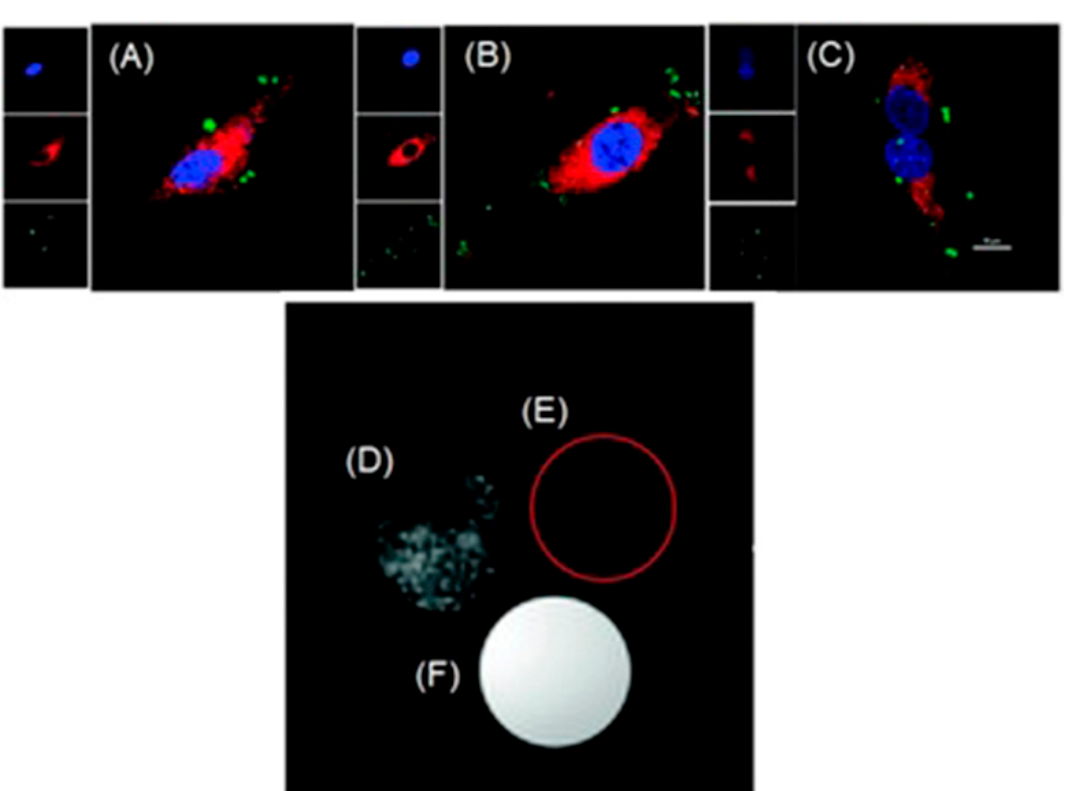
Figure 33. In vitro studies of the nanoparticles. Confocal fluorescence micrographs of nanoparticles incubated with ( A ) normal human lung fibroblast cells (MRC-5) for 3 h, ( B ) human lung cancer cells (A549) for 30 min, and ( C ) A549 cells for 3 h. Nuclei of all the cells are stained red, and nanoparticles are shown as green spots. These results indicate that the nanoparticles are selectively endocytosed by lung cancer cells (A549). In vitro studies. 19 F-MRI images of fluorinated nanoparticles in ( D ) pH 7.4 buffer (phosphate-buffered saline), ( E ) A549 lung cancer cells, ( F ) pH 6.0 buffer (phosphate-buffered saline), where incubation was performed for 1 h. Field of view = 33 × 33 mm 2 . Adapted with permission of the Royal Society of Chemistry, from pH/temperature-sensitive magnetic nanogels conjugated with Cy5. 5-labeled lactoferrin for MR and fluorescence imaging of glioma in rats, Jiang, L.; Zhou, Q.; Mu, K.; Xie, H.; Zhu, Y.; Zhu, W.; Zhao, Y.; Xu, H.; Yang, X. 34 , 3, 2013 ; permission conveyed through Copyright Clearance Center, Inc.